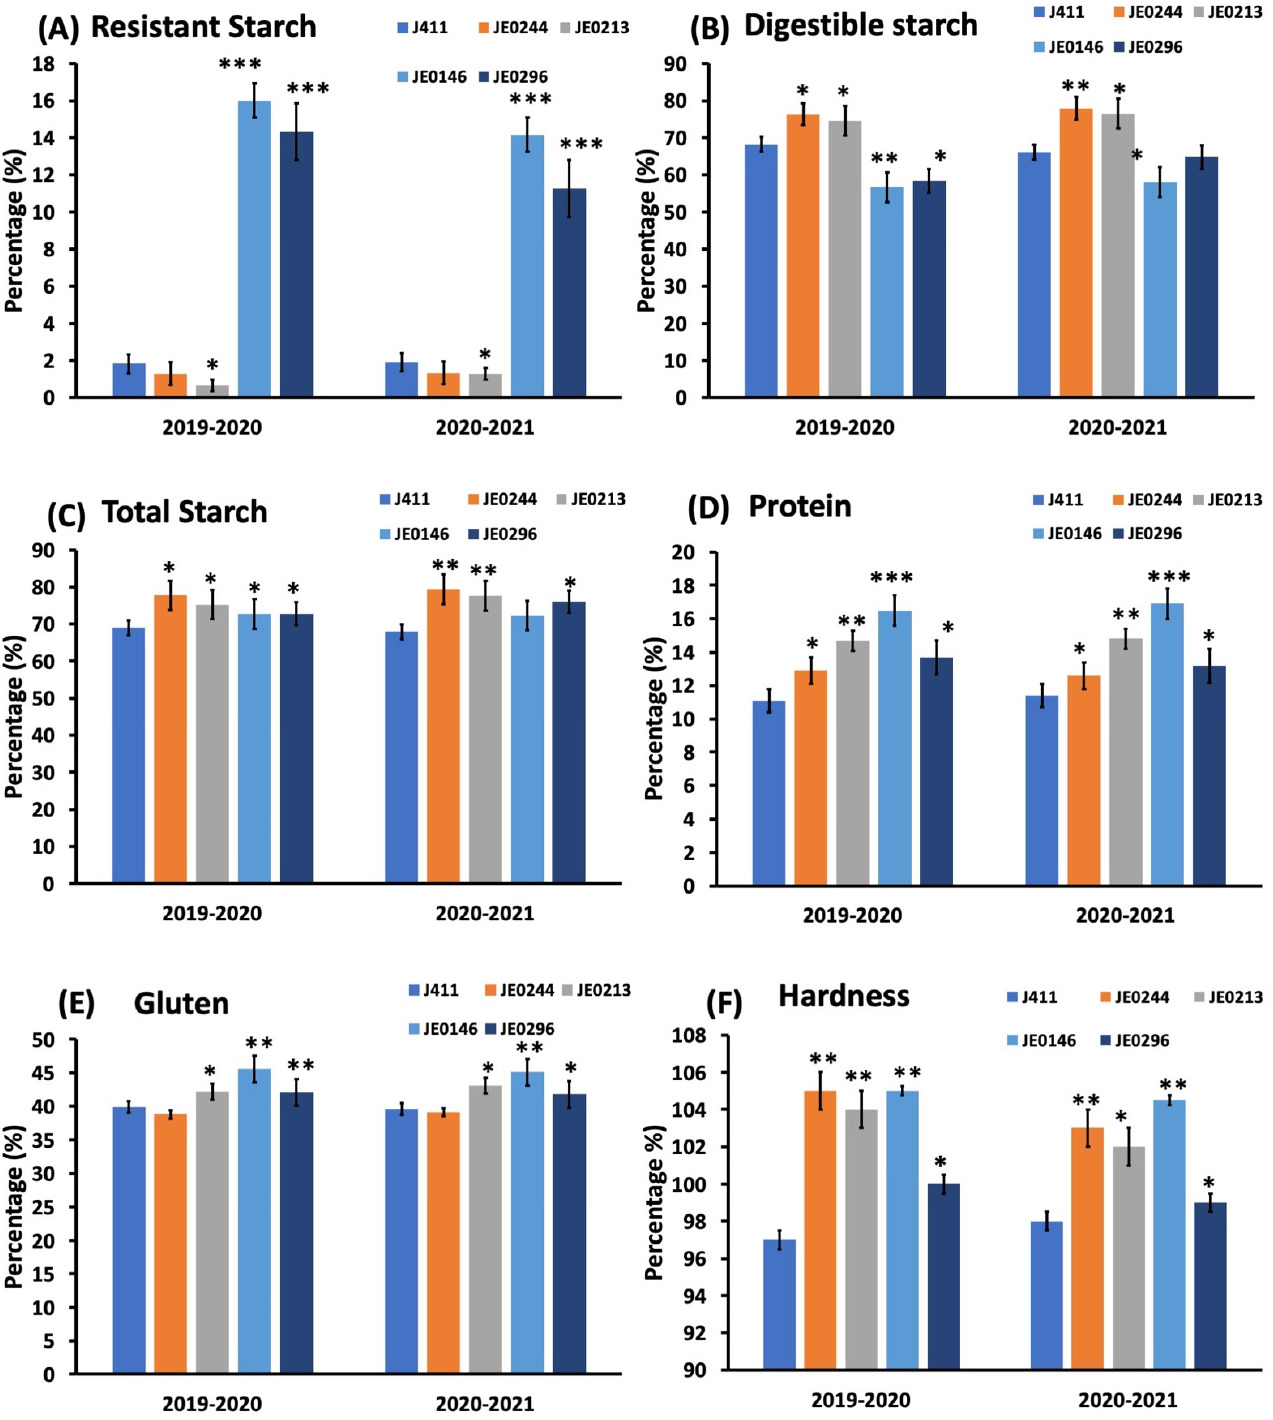
Figure 2. Representative mutants with altered resistant starch content and other physiological traits in the selected lines in 2019–2020 and 2020–2021: ( A ) resistant starch; ( B ) digestible starch; ( C ) total starch; ( D ) protein; ( E ) gluten; and ( F ) hardness. Asterisks (*, **, ***) indicate that the trait mean was significantly different ( p -value < 0.01) between the WT and mutant lines.